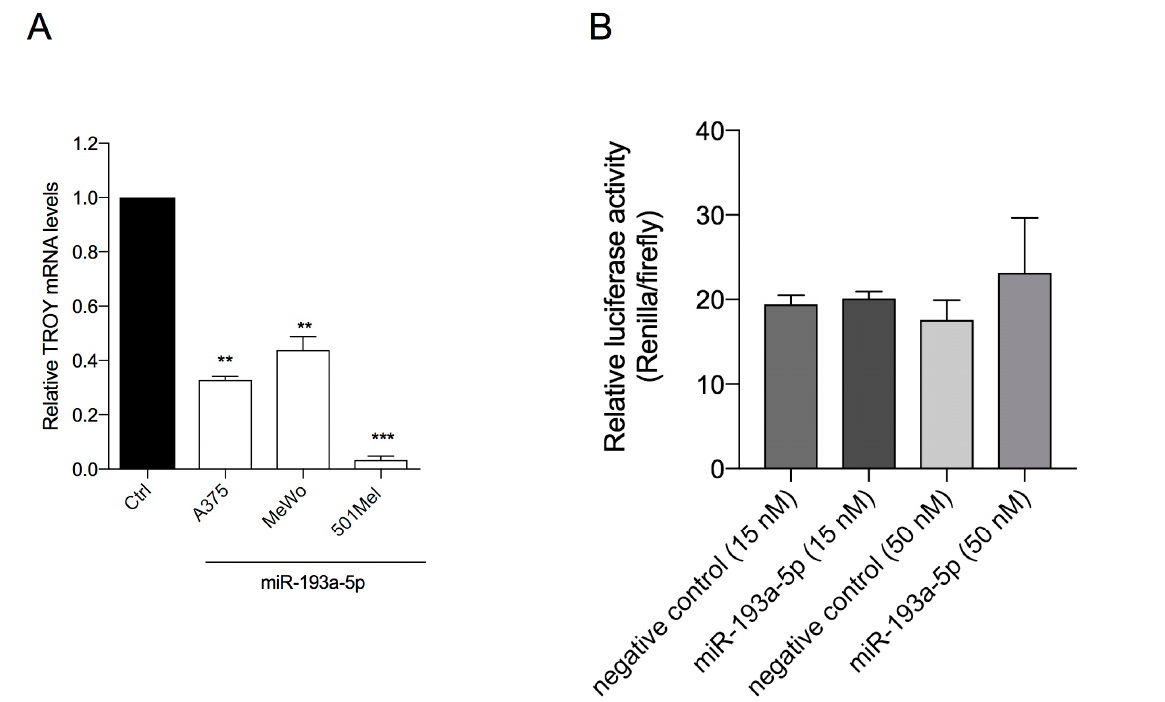
Figure 6. ( A ) Ectopic over-expression of miR-193a-5p reduces TROY transcriptional expression levels in A375, MeWo, and 501Mel cells. Data are representative of three independent experiments ± SD performed in triplicate. Statistical analysis was performed by Student’s t -test (** p < 0.01, *** p < 0.001, compared to corresponding control). ( B ) Luciferase assay analysis for miR-193a-5p and TROY mRNA 3 ′ -UTR interaction. Luciferase assay signal did not show any downregulation by miR-193a-5p compared to the negative control .